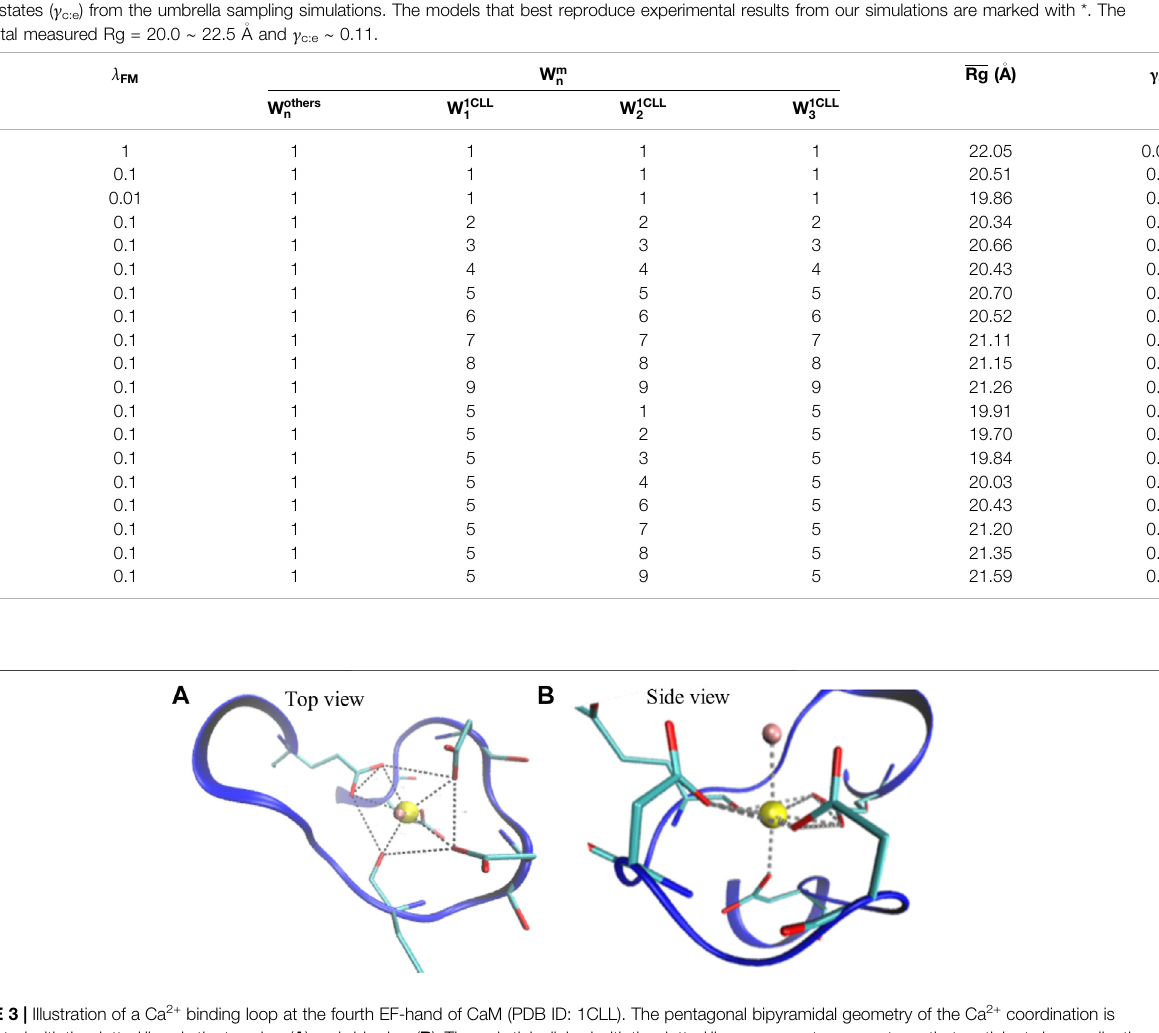
FIGURE 3 | Illustration of a Ca 2+ binding loop at the fourth EF-hand of CaM (PDB ID: 1CLL). The pentagonal bipyramidal geometry of the Ca 2+ coordination is represented withthedottedlines inthe topview ( A )and sideview ( B ).Thered stickslinked withthedottedlines representoxygenatoms thatparticipateincoordination. The water molecule, shown in pink, completes the spherical coordination through hydrogen bonding.